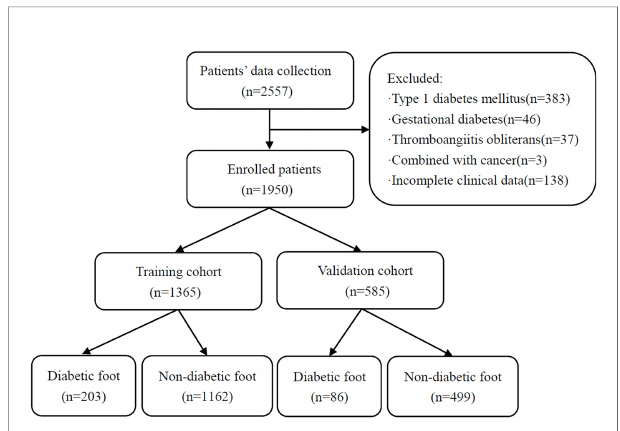
FIGURE 1 | Flowchart of patients included in this